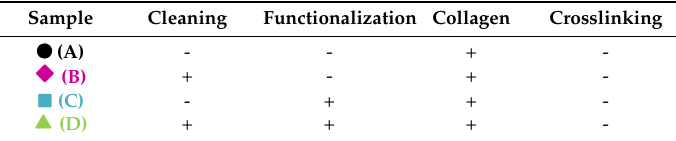
Table 2. Selected scaffolds. Collagen release was determined depending on the cleaning and functionalization process (- not applied, + applied). Sample Cleaning Functionalization Collagen Crosslinking